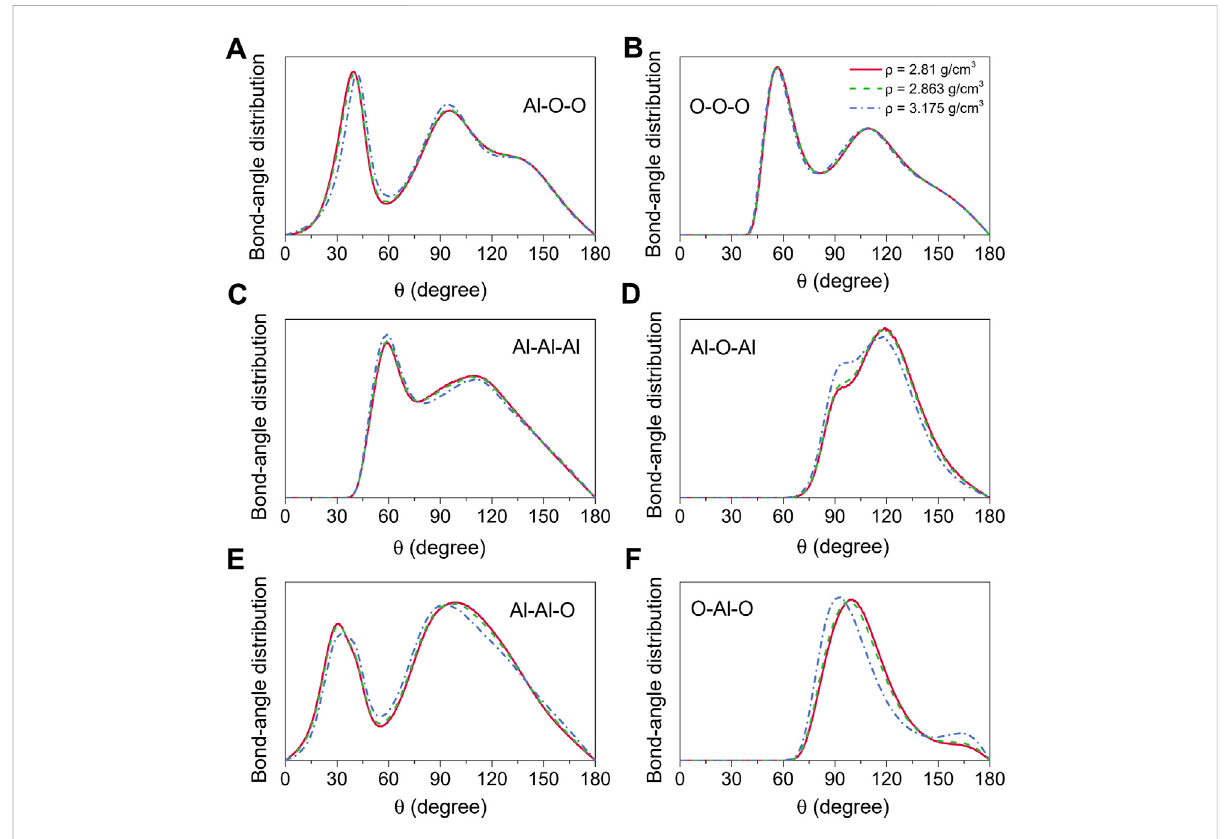
FIGURE 6 Bond-angle distributions for liquid alumina at 2500 K and three densities, (A) Al-O-O, (B) O-O-O, (C) Al-Al-Al, (D) Al-O-Al, (E) Al-Al-O and (F)